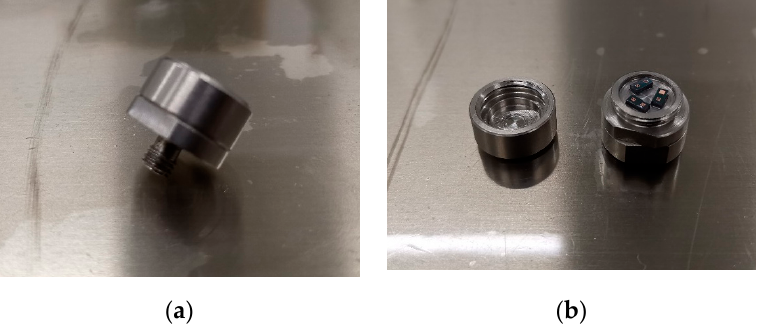
Figure 9. The shell with inductor dies for shock test. ( a ) The designed test shell structure. ( b ) The test shell with inductor dies.